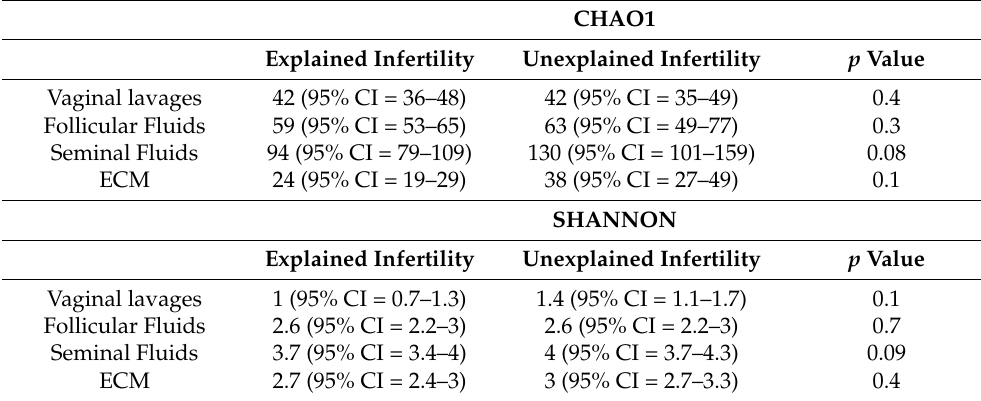
Table 1. Alpha diversity. The bacterial diversity values are given as the mean and the 95% confidence interval (CI). All of the pairwise comparisons were performed using a Kruskal–Wallis test ( p < 0.001). ECM: embryo culture medium.